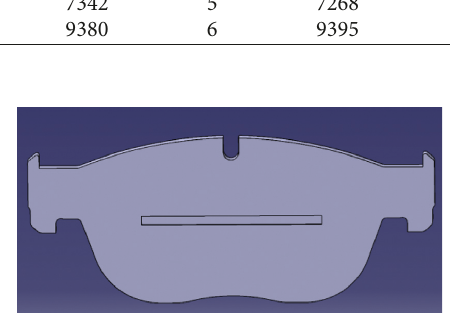
Figure 8: Sample 3 (three horizontal slots).